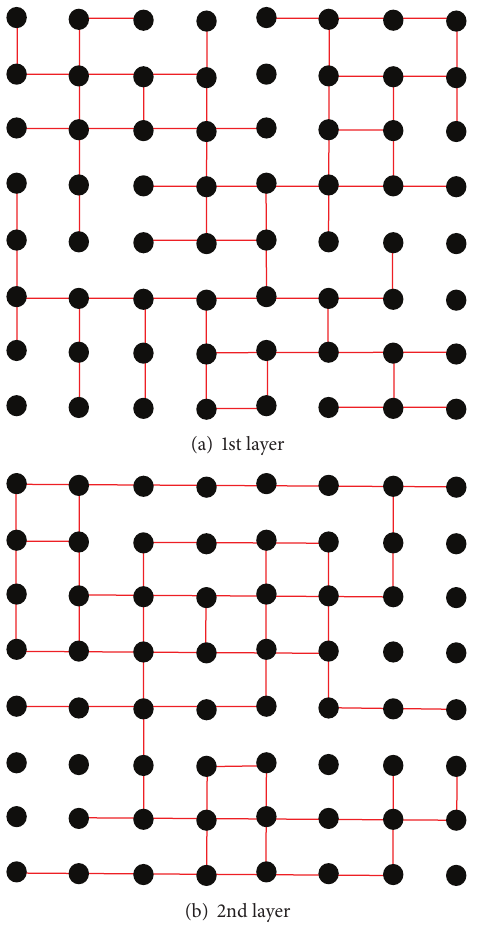
Figure 9: Final wiring tracks on each